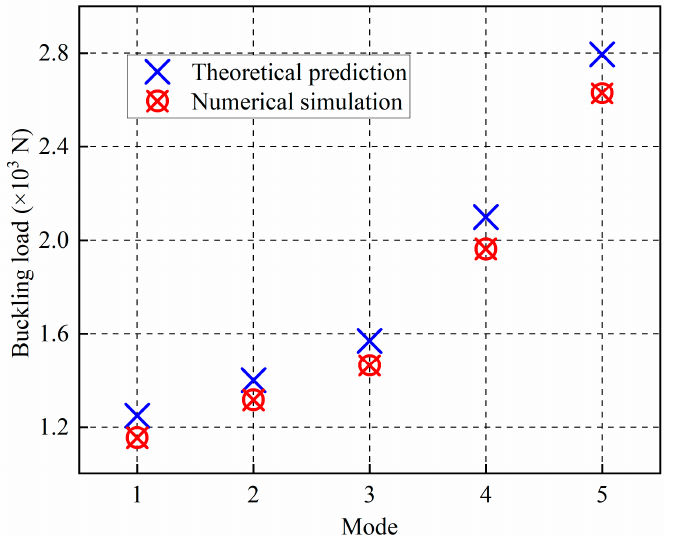
Figure 3. The first five buckling modes for the composite plate.